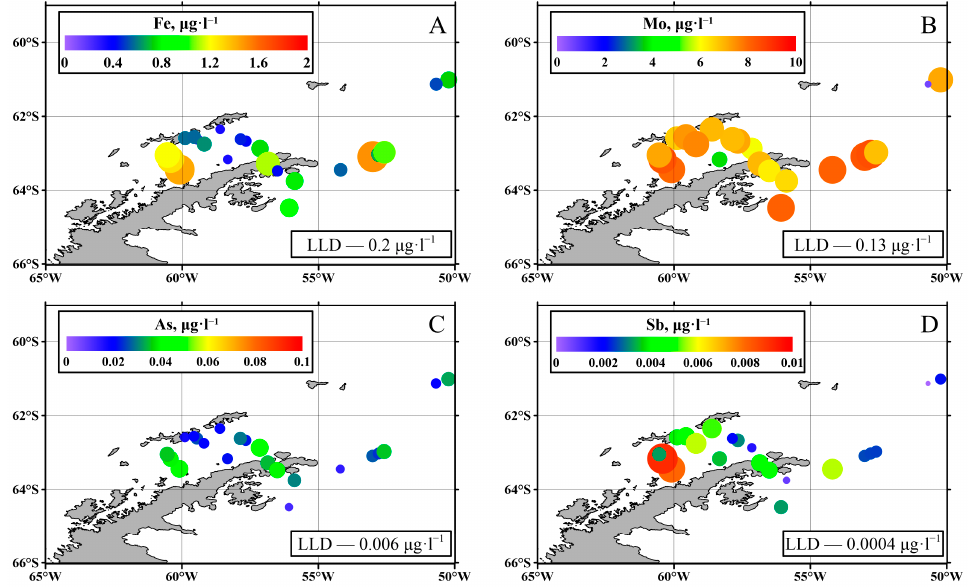
Figure 7. Concentrations of Fe ( A ), Mo ( B ), As ( C ), and Sb ( D ) in surface waters of the studied area of the Antarctic